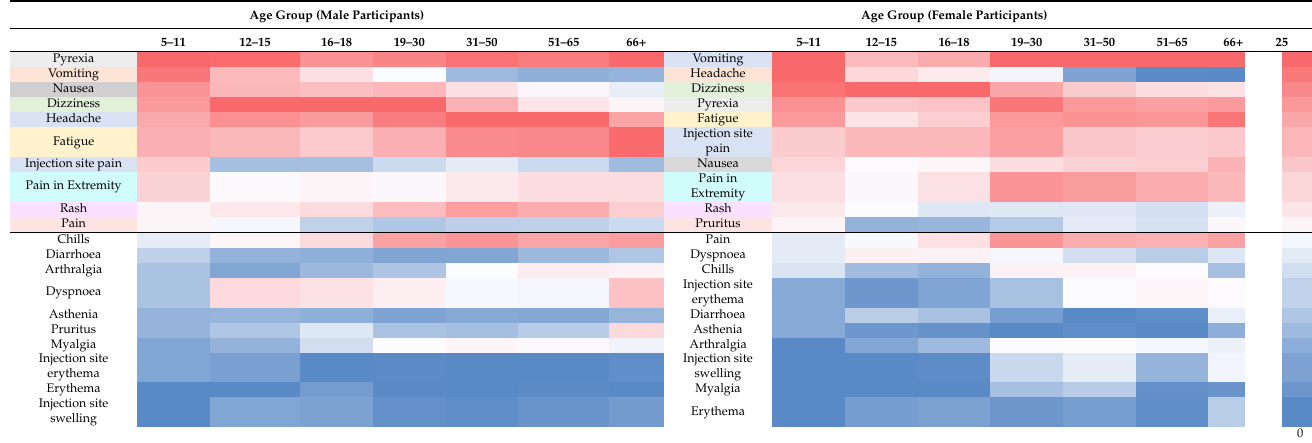
Table 2. The 20 most commonly reported AEs ranked with respect to the age groups and gender based on the percentage of VAERS samples reporting the corresponding AE (minimum 0% to maximum 25%). Heatmap cells are colored according to the percentage of reported samples, and the AEs are sorted according to the percentage of reported VAERS samples for age group